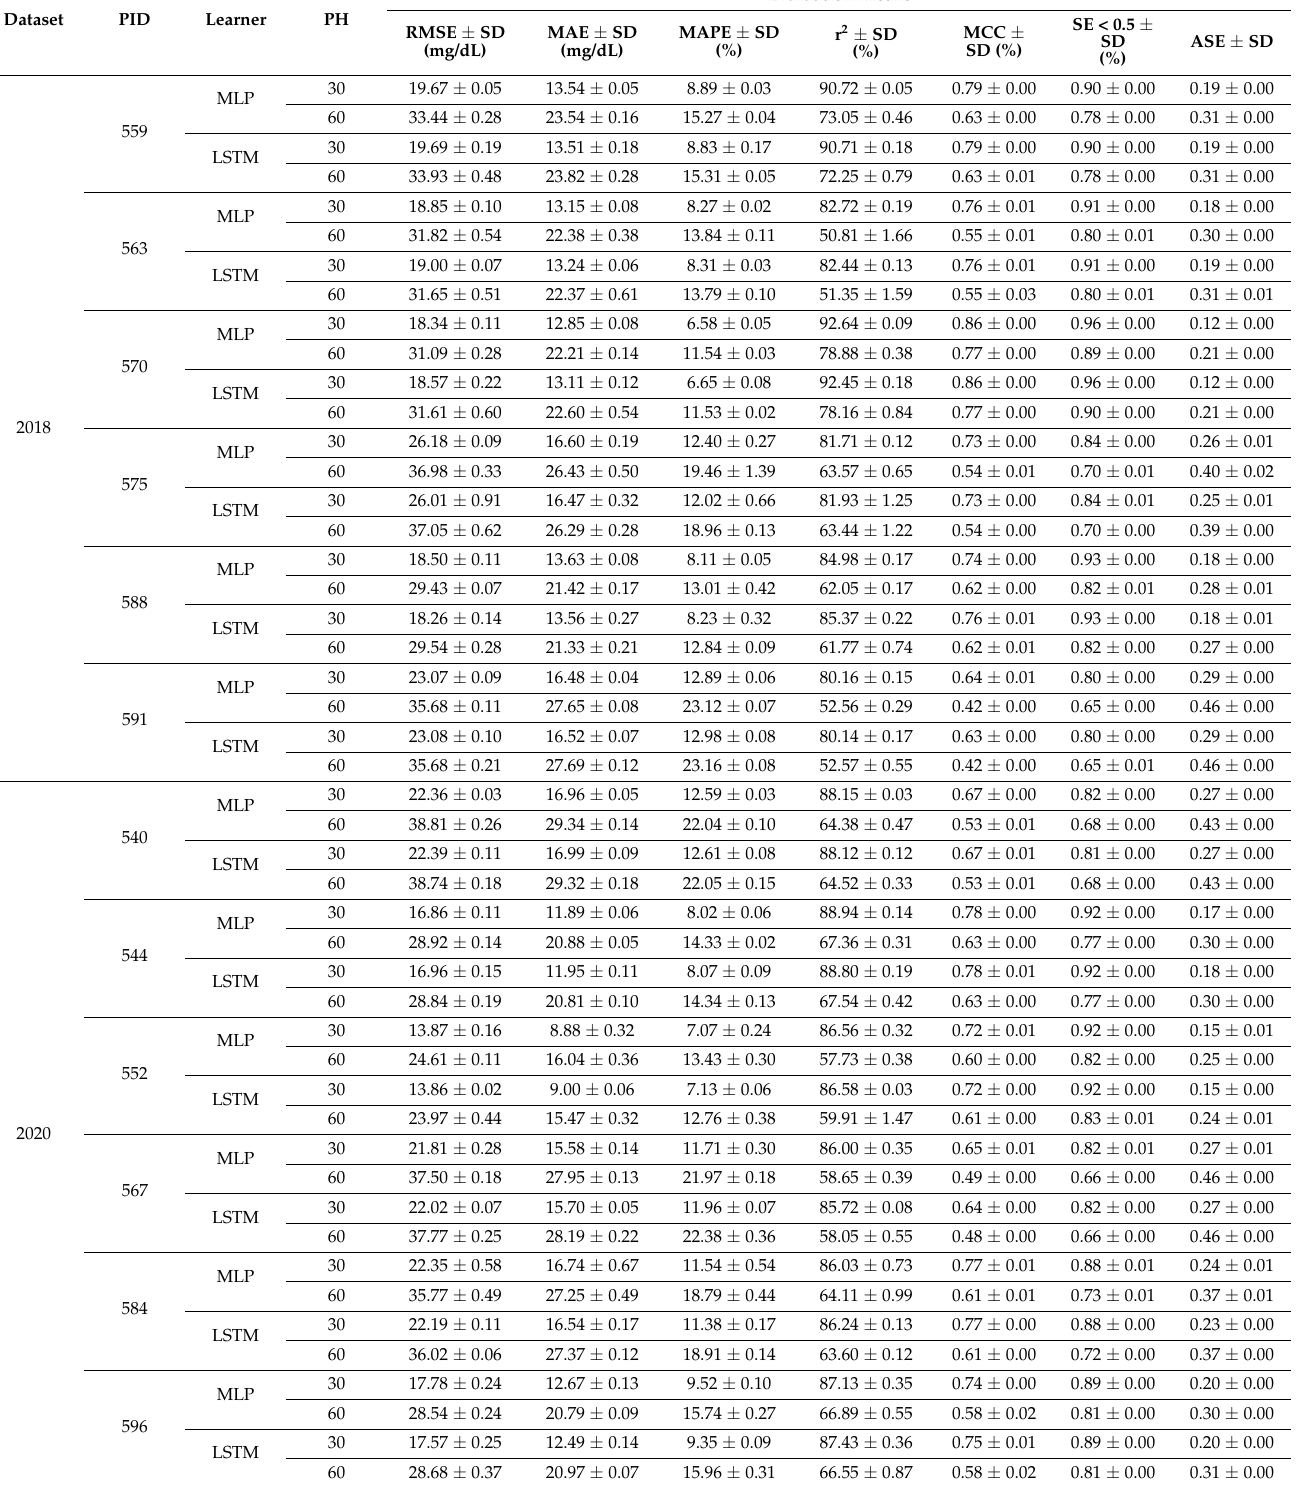
Table 4. The evaluation results for the nested stacking models created using Ohio